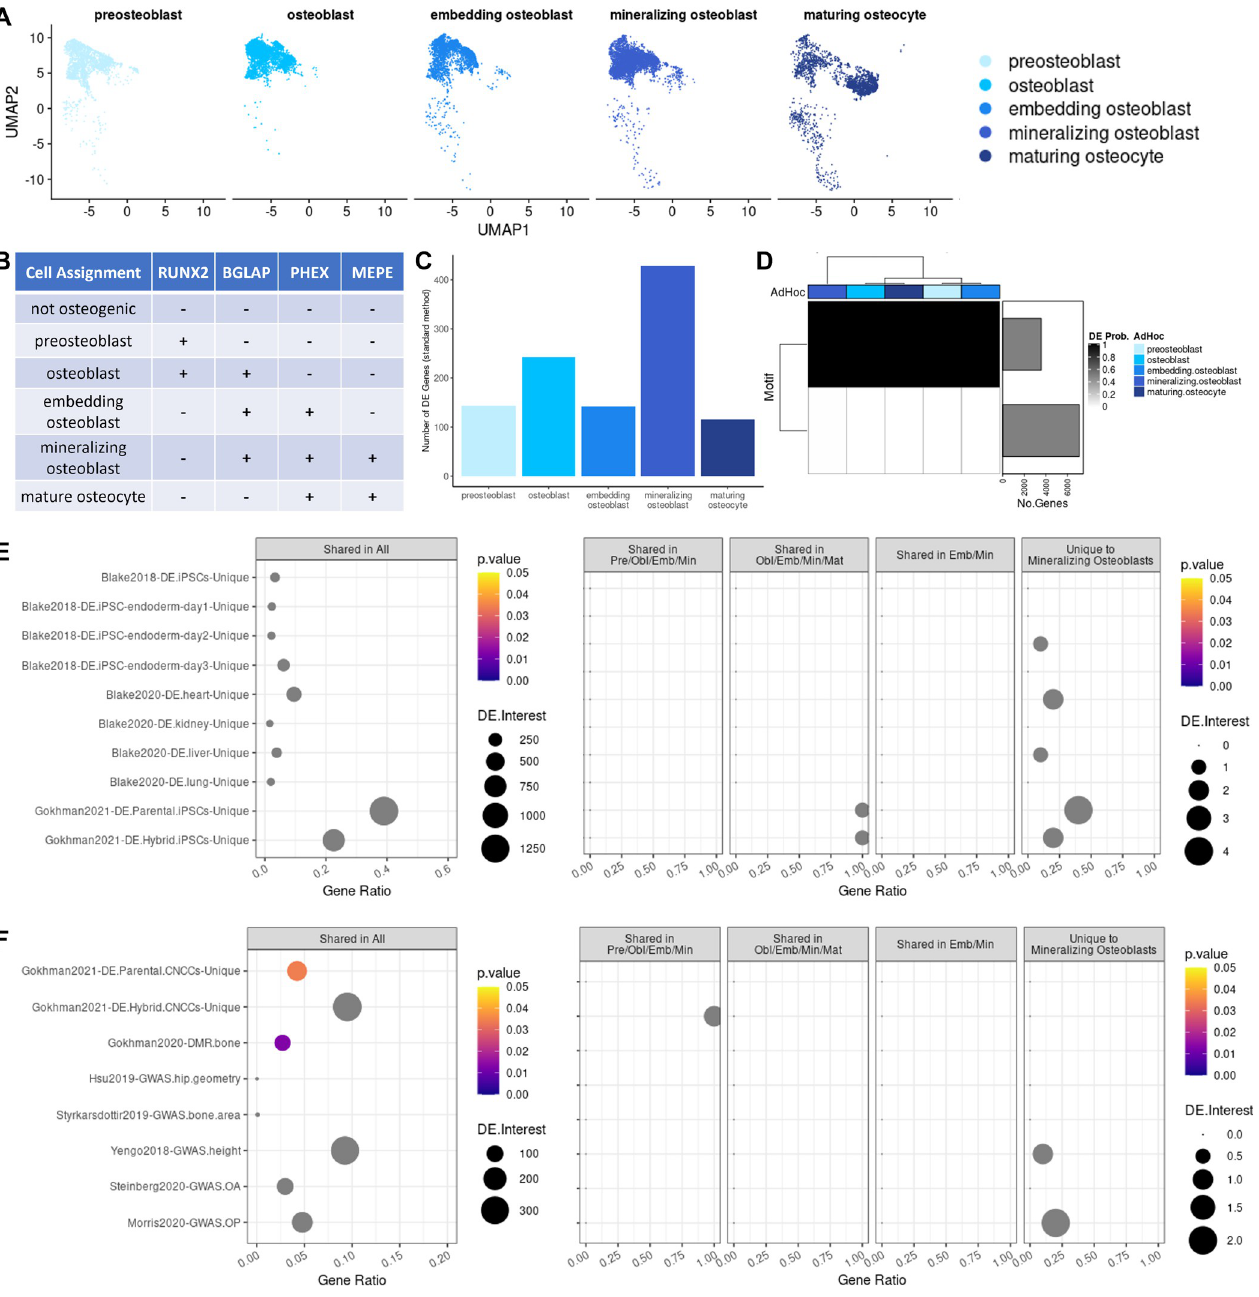
Fig 4. Interspecific DE across five substages of osteogenesis. UMAP dimensional reduction plot of scRNA-seq data with cells labeled by the stage of osteogenesis to which they were assigned (A), along with a simplified schematic of the osteogenic ad hoc assignment method. Bar plot showing the number of interspecific DE genes identified for each stage of osteogenesis using standard methods (C). Correlation motifs based on the probability of differential expression between species for each osteogenic ad hoc assignment with the number of genes assigned to each motif shown in the bar plot on the right and the posterior probability that a gene is DE shown by the shading of each box (D). Enrichment of external DE gene sets among Cormotif interspecific DE genes identified for each stage of osteogenesis for validation (E) and functional interpretation (F) with the p-value (p.value), the number of DE genes overlapping an external gene set (DE.Interest), and the ratio of overlapping to non-overlapping DE genes for a given external gene set (GeneRatio) denoted.